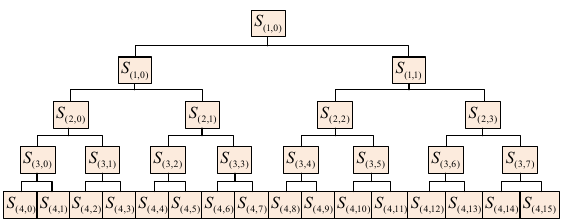
Figure 3. Schematic diagram of 4-layer wavelet packet decomposition.